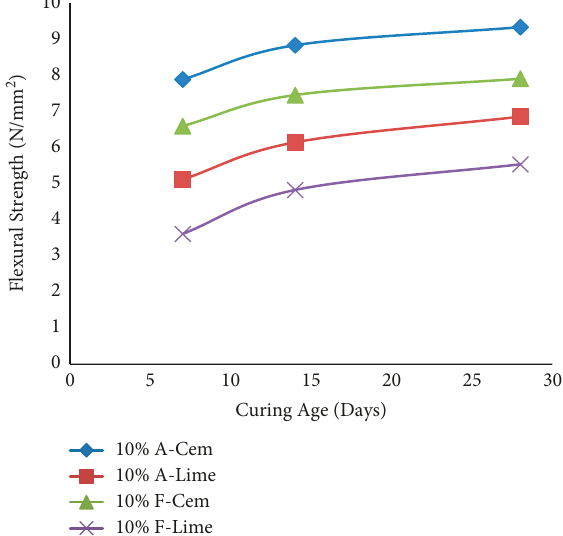
Figure 6: Flexural strength of bagasse ash concrete at 10%